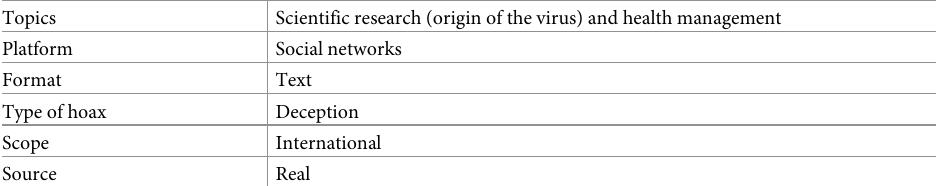
Table 13. Most common characteristics of hoaxes about science and health.